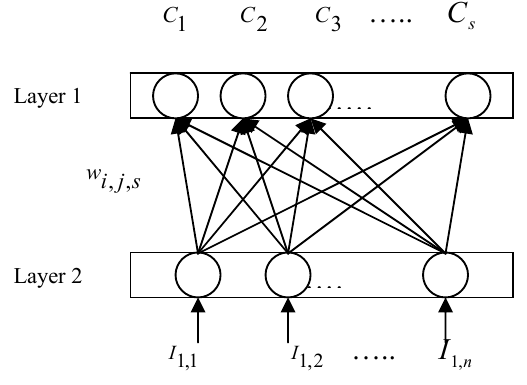
Fig. 1. The Fuzzy ART